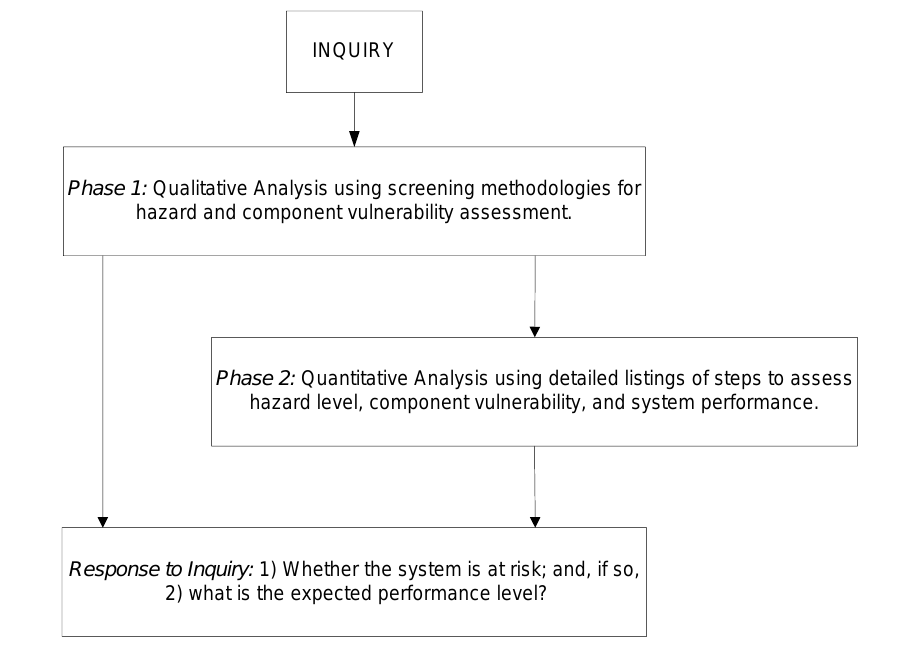
Figure 4. Two-Phase Approach to Performance Assessment (ALA, 2005) Table 2. Descriptions of different damage states in HAZUS and RISK-UE methods